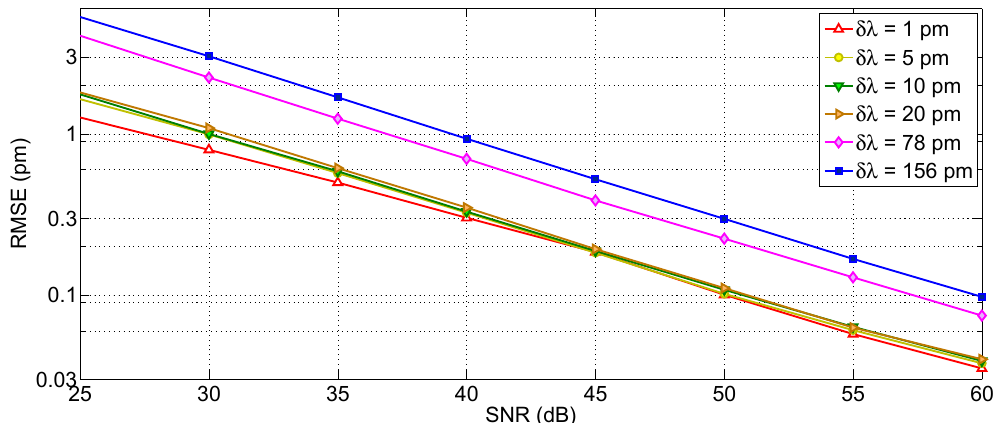
Figure 22. Performance analysis of spline peak tracking technique: the RMSE on peak detection is reported as a function of SNR, for different values of sampling grid δλ (1 pm, 5 pm, 10 pm, 20 pm, 78 pm, 156 pm); the spline coefficients have been estimated on the original grid and reevaluated over a grid with 0.1 pm resolution.